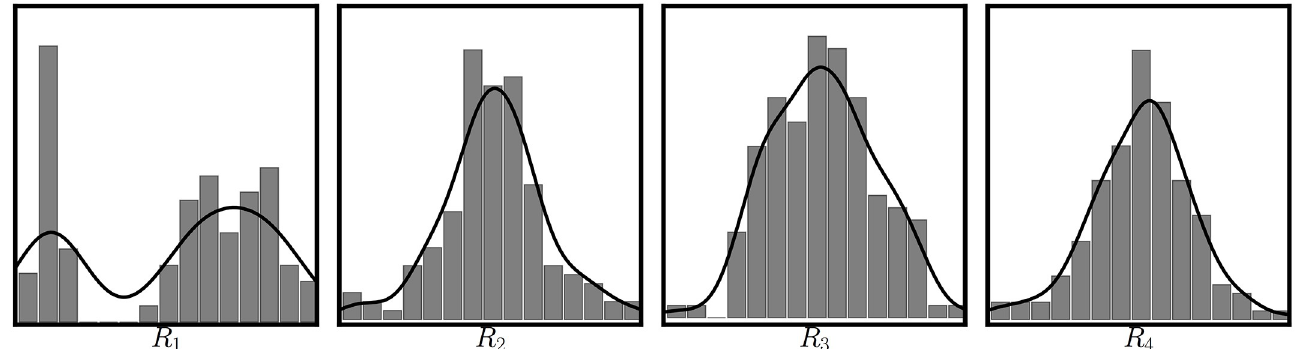
Fig 7. Histograms of extractedsources from the Iris data. Each panel shows a histogram(bars) and kernel density estimate (Gaussian kernel, solid line) for one of the four RAICAR sources extracted from the iris data. The nongaussianity of the most reproducible source (upper left) is clearly